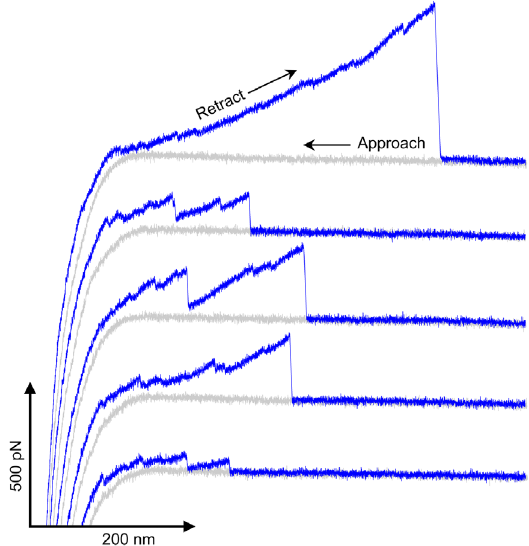
themselves.FIG. 8. Force-extension curves indicating the pulling of actin filaments from a SMC nanotube. This graph displays five distinct approach-retract cycles of the AFM tip. The retract curves clearly show some force peaks, indicating that the AFM tip pulls actin filaments or actin filament networks out of the nanotube surface when moving upward. The sudden drops in force in the retract curves indicate when the actin filaments or actin filament net- works either unfold or detach from the AFM